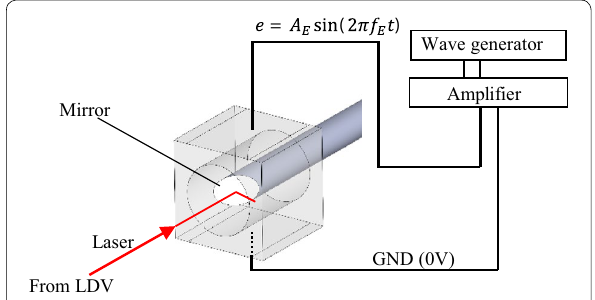
Fig. 5 Experimental setup for laser Doppler velocimetry